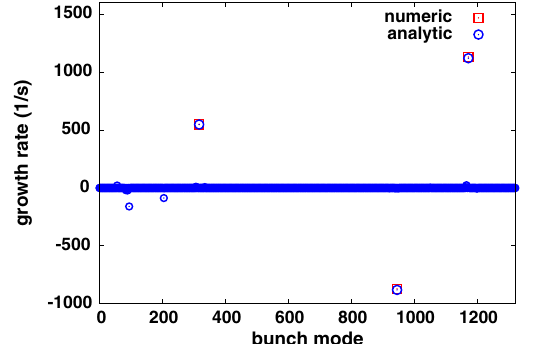
FIG. 4. Growth rates of bunch modes μ for the uniform filling pattern case with M ¼ h ¼ 1320 , calculated analytically (blue circle) and numerically with SPACE (red square) showing close agreement. The numerical results are shown only for the three modes, μ ¼ 1170 , 944 and 316, with the largest absolute value of the growth rate.